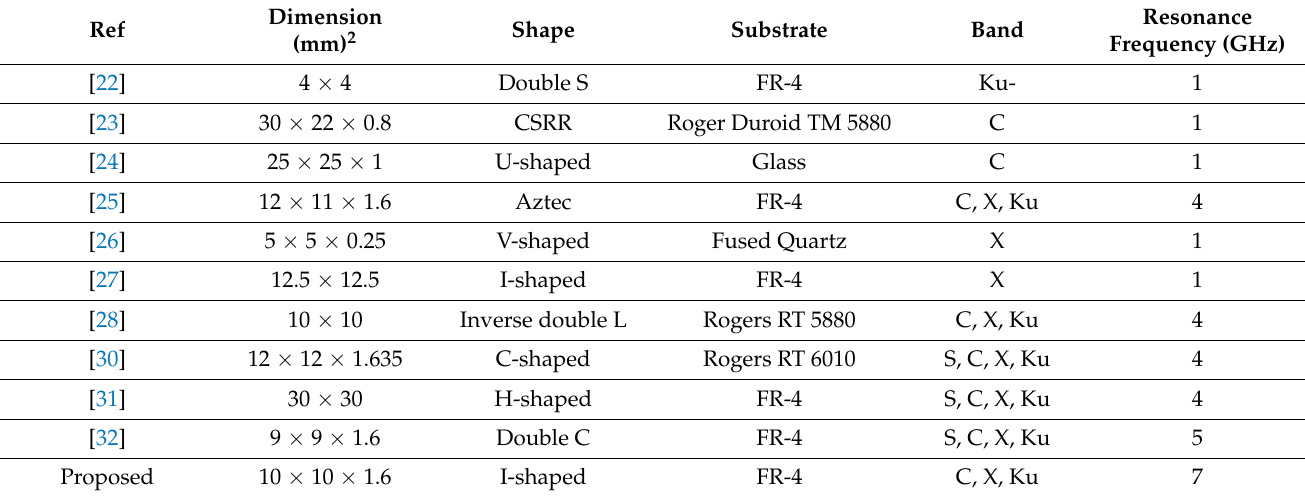
Table 4. Comparative analysis of the proposed ISMeTM with the structures in